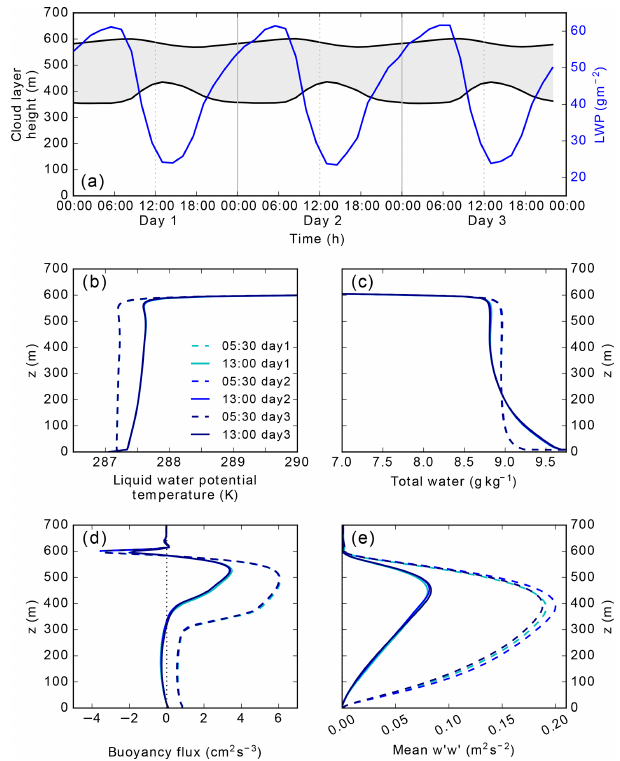
Figure 3. Evolution of domain averaged cloud properties in the no- aerosol simulation including (a) cloud top and base (black lines; left axis), liquid water path (blue line; right axis), and vertical profiles taken at 05:30 (dashed lines) and 13:00 (solid lines) on each day for (b) liquid water potential temperature, (c) total water mass mixing ratio, (d) buoyancy flux, and (e) the variance in vertical velocity w (cid:48) w (cid:48)